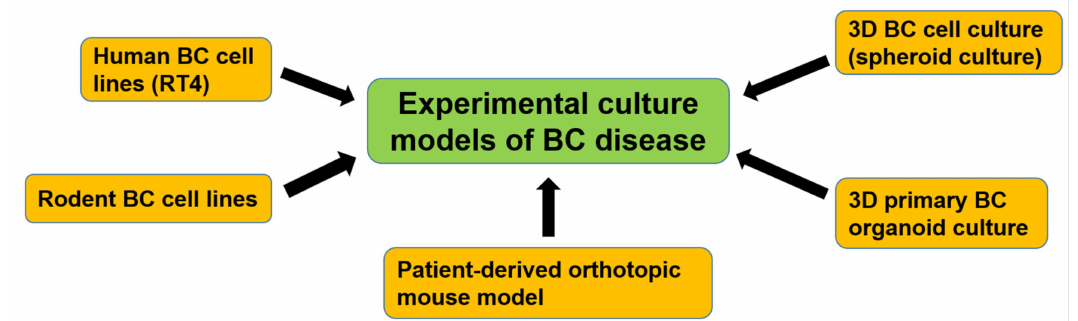
Figure 3. Development of experimental culture models of BC disease. Human and rodent BC cell lines were first developed and used for basic BC research. To study the mechanisms of bladder CSCs, 3D BC cell culture (spheroid culture) was developed. Recently, a 3D primary BC organoid culture method was established, which includes patient-derived bladder CSCs and can mimic the bladder tumor microenvironment. A patient-derived orthotopic mouse model was also established and could recapitulate clinical urothelial cell carcinoma progression and